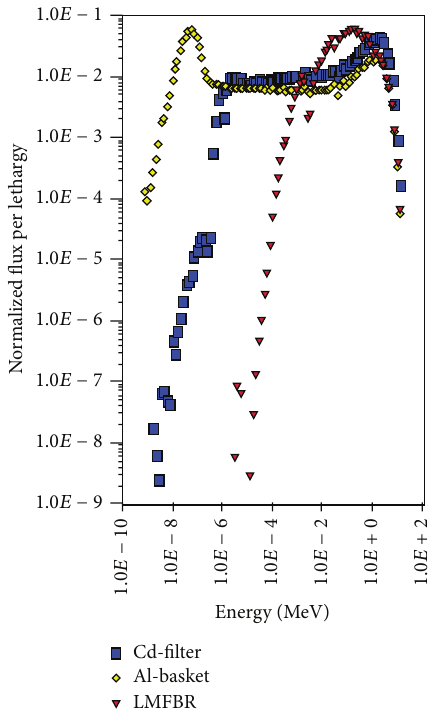
Figure 9: Comparison of fast-fission spectrum (LMFBR) with the neutron spectrum produced with and without Cd [9].